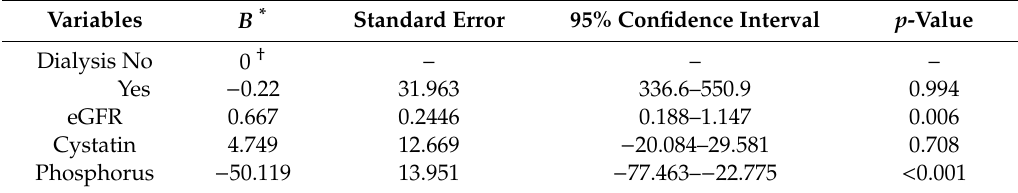
Table 5. The generalized linear model between renal parameters and subfoveal choroidal thickness.